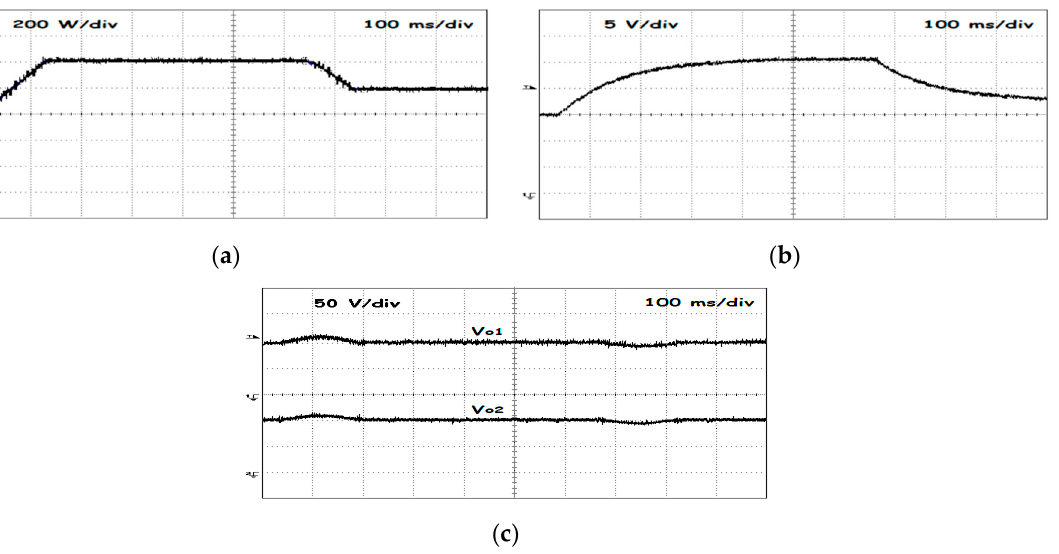
Figure 14. Obtained experimental waveforms when the system is subject to a change in the solar irradiance: ( a ) solar irradiation applied to the PV panels, ( b ) speed of the SRM motor (22.5 V → 1000 rpm), ( c ) DC/DC output voltages.